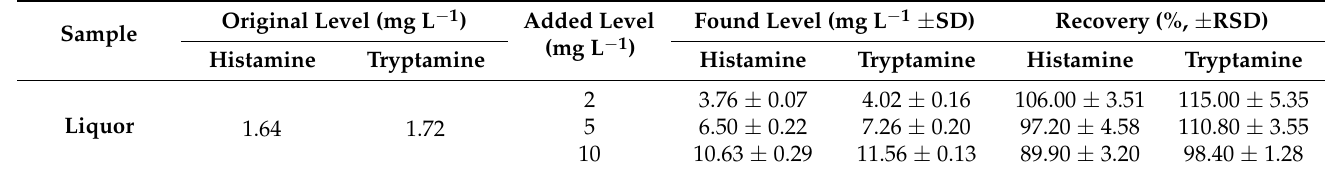
Table 1. Recovery tests for histamine and tryptamine in spiked liquor samples using the BELISA (n =